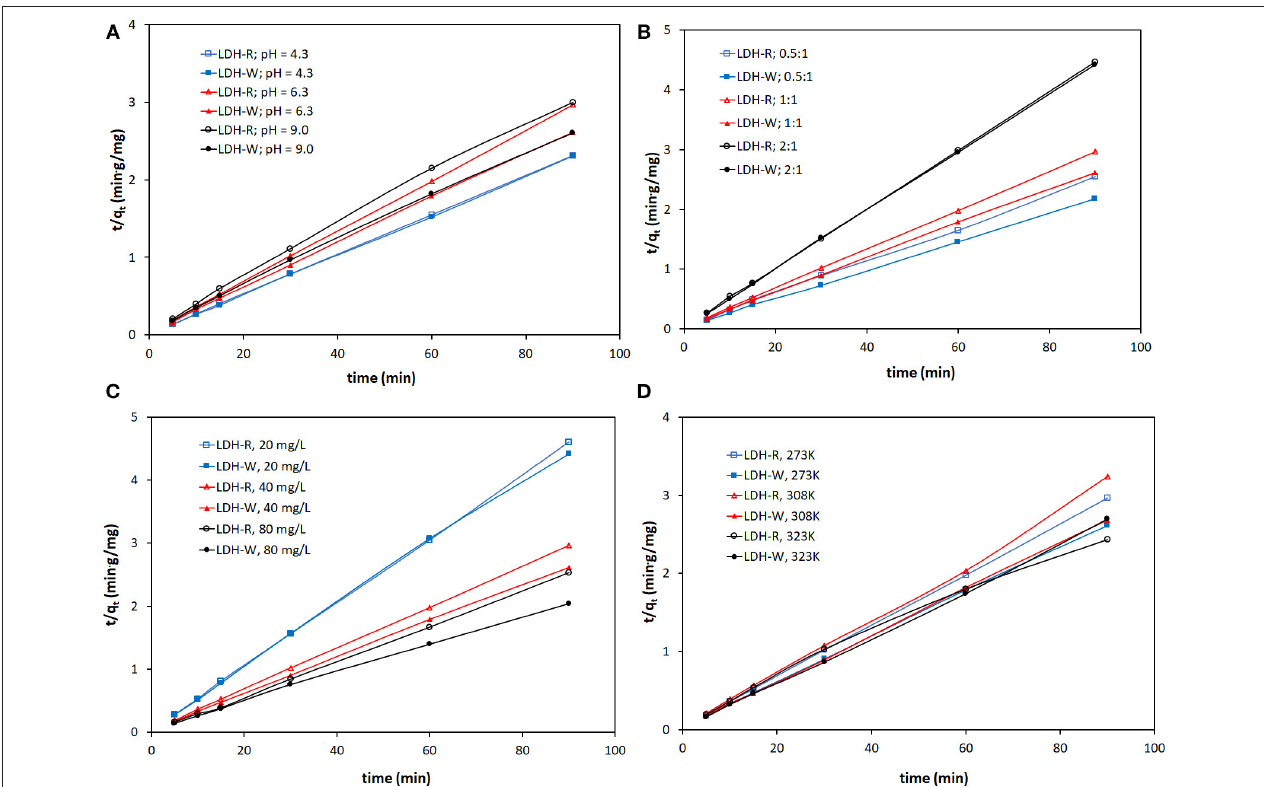
FIGURE 5 | Pseudo-second-order kinetic models for adsorption of Orange II at: (A) different pH; (B) different S:L ratio; (C) different dye concentrations; (D) different temperatures.